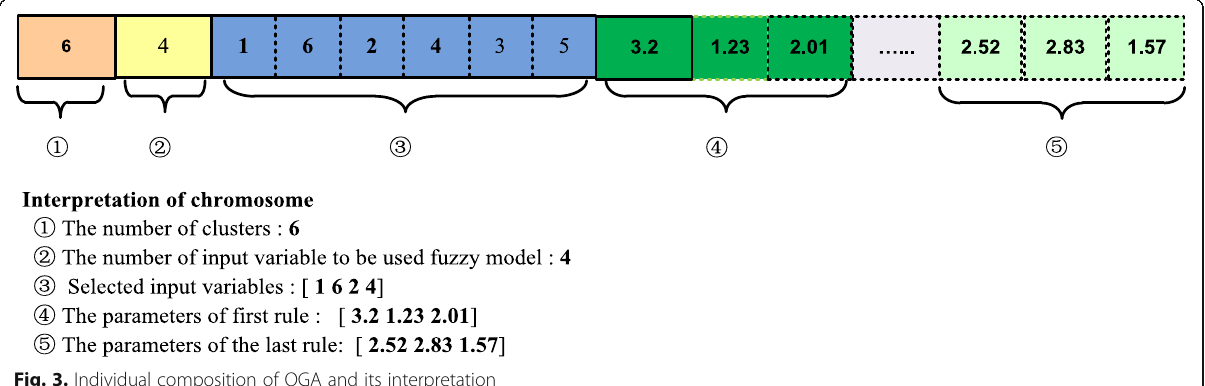
Fig. 3. Individual composition of OGA and its